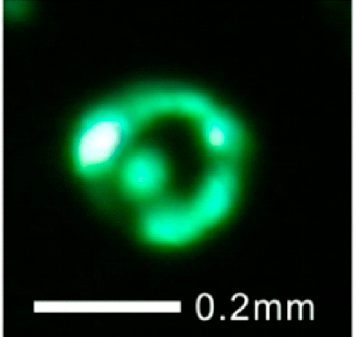
Figure 11. Field-emission ring pattern of individual ZnO nanowire. Reproduced from [70], with the permission of IOP Publishing,